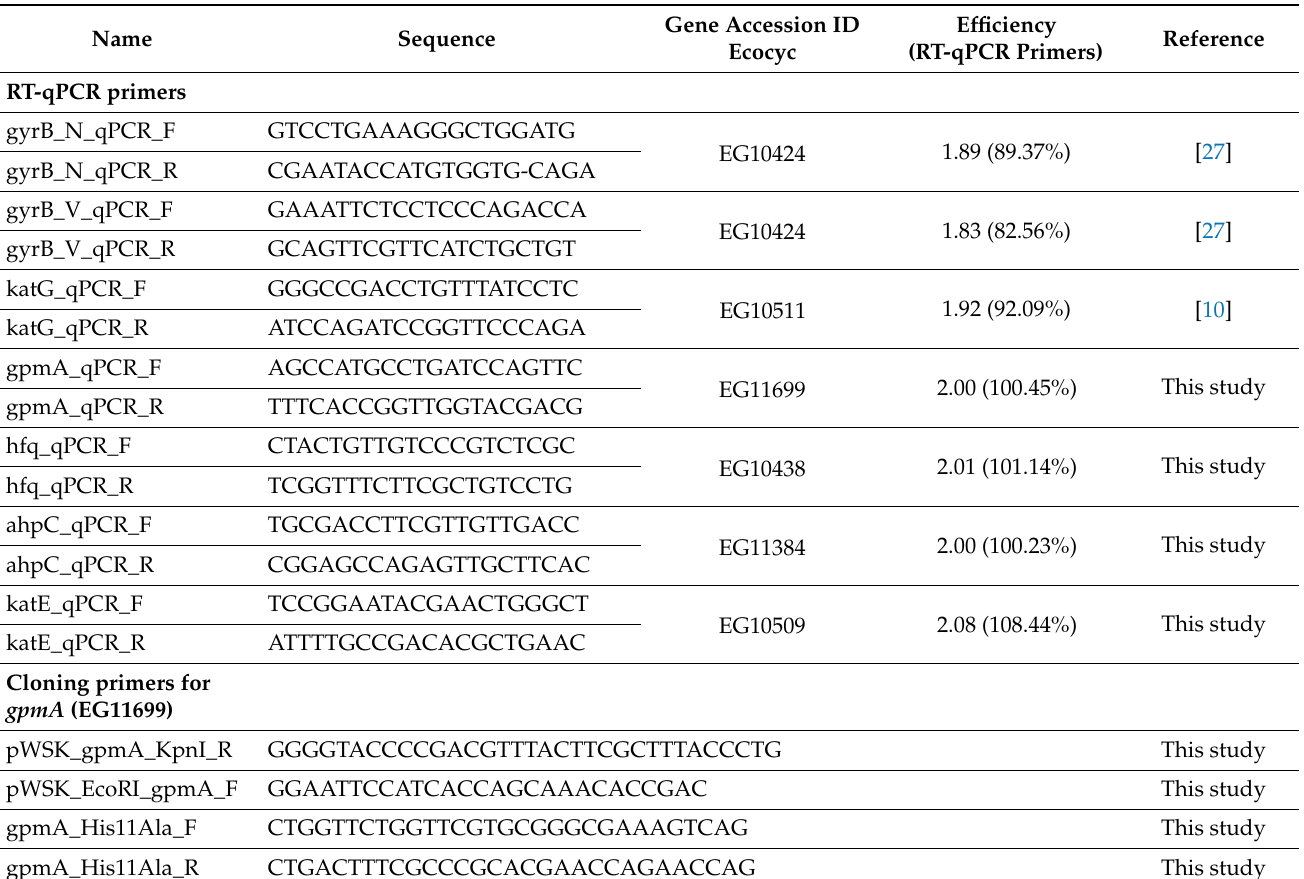
Table 2. Primers used in this